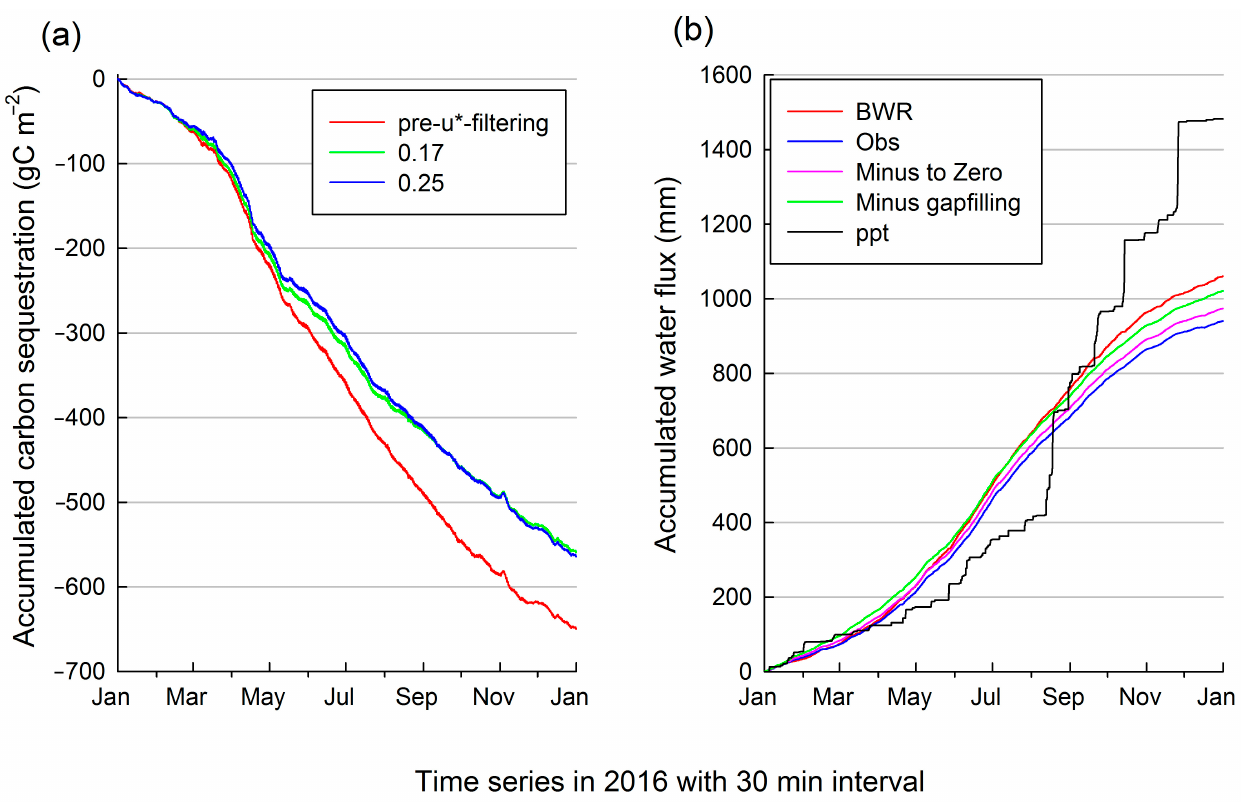
Figure 8. The accumulated carbon and water fluxes. ( a ) accumulated carbon sequestration. The red, green, and blue lines indicate no u * filtering ( u * is the friction velocity, annual sum of − 1 (annual sum of − 559 gC m − 2 s − 1 ), and a threshold − 649 gC m − 2 s − 1 ), a threshold u * of 0.17 m s u* of 0.25 m s − 1 (annual sum of − 563 gC m − 2 s − 1 ), respectively. ( b ) accumulated water fluxes. The red, blue, pink, green, and black lines represent the accumulated water flux obtained from the Bowen ratio energy balance correction (1060 mm), gap filling the observation data (940 mm), treating all negative fluxes as zero (973 mm), treating all negative fluxes as gaps and filling the gaps (1020 mm), and the precipitation (1482 mm),